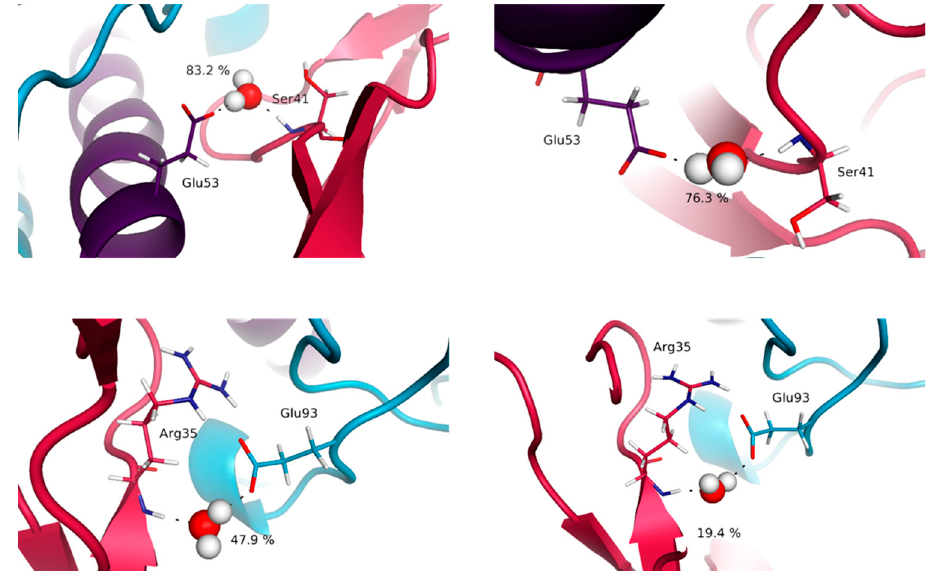
Figure 9. Representation of key bridging water molecules at the IL-15/IL-15R α interface for the full system ( left ) and the dimeric system ( right ). The values indicated correspond to the percentage of presence of the water molecules along the simulation time.